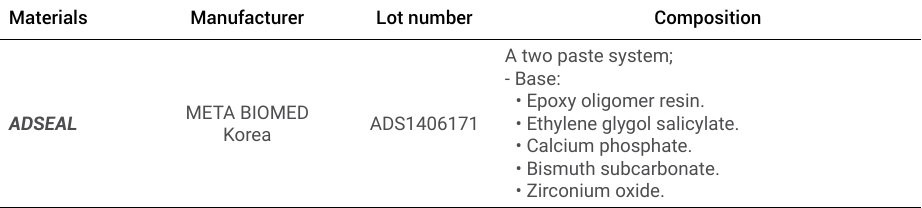
Table 1. materials used in this study, their manufacturer, lot number and